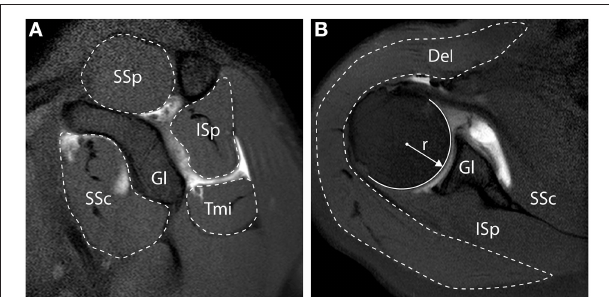
FIGURE 1 | Measurements of muscle cross-sectional surface area from MR Arthography. (A) Sagittal view. Cross-sectional surface areas (CSA) of the supraspinatus (SSp), infraspinatus (ISp), teres minor (Tmi), and subscapularis (SSc), relative to the glenoid (Gl) are depicted. (B) Transversal view. CSA of the deltoid (Del) is depicted. All CSAs were normalized to the surface of the humeral head, calculated based on the radius of the humeral head ( r